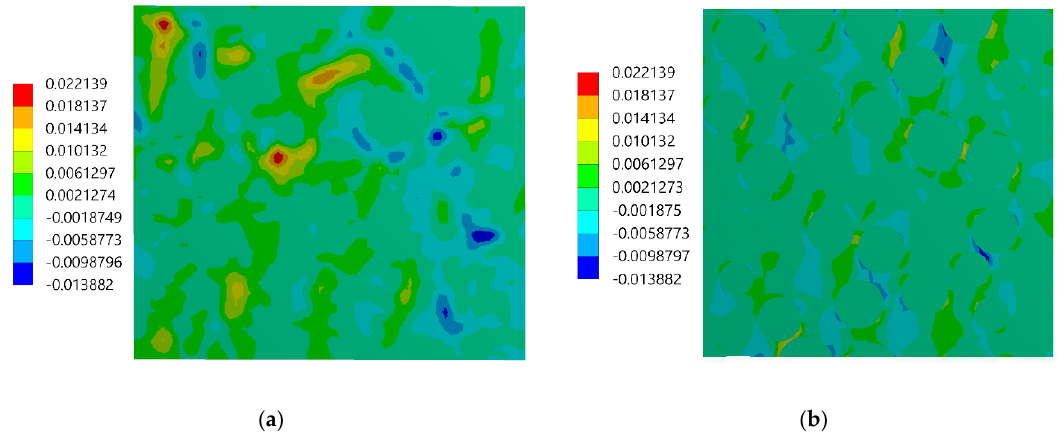
Figure 14. Strain ε yy distributions: ( a ) experimental results (DIC), ( b ) numerical results (FEM).